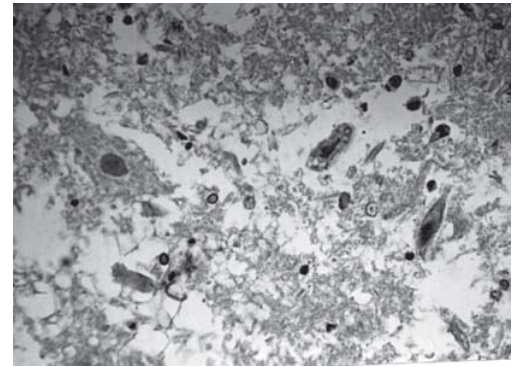
Fig. 7 - Animals with grade III injury (complete widespread neuronal